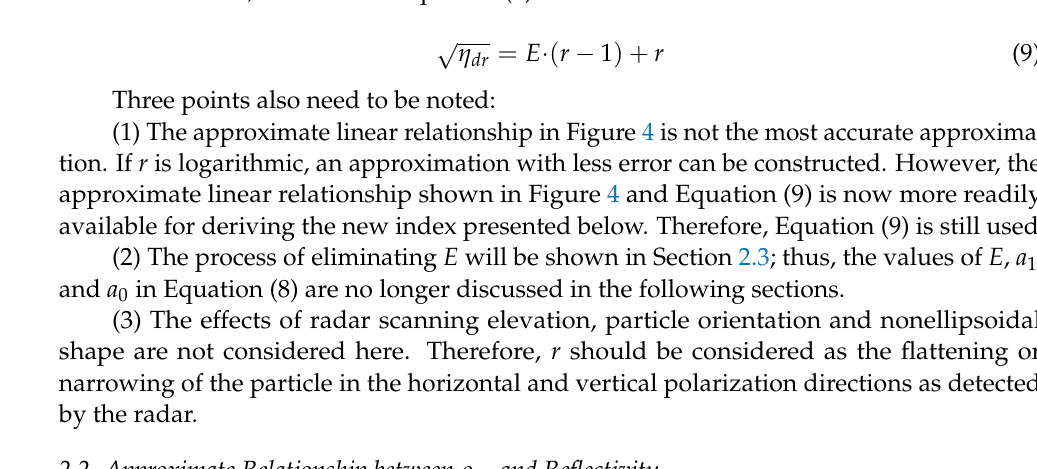
Figure 4. Linear approximation between m r , η dr and r of a single ellipsoidal particle. ( R 2 is the goodness of fit, and P is the significance of the linear fit. ( a ) S-band, ( b ) X-band.